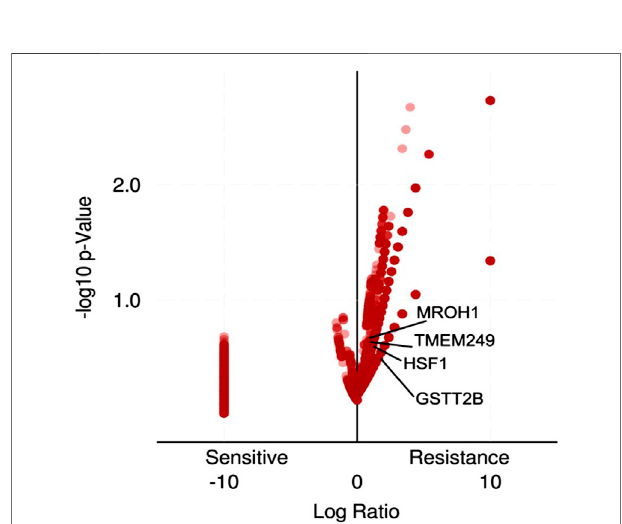
FIGURE 7 | Volcano plot enrichment analysis for gene-related protein expression in ovarian cancer patients who were treated with chemotherapy from TCGA using TCGAbiolinks. The expression of HSF1, TMEM249, and MROH1 proteins signi fi cantly increased in resistant patients ( n = 90) versus sensitive patients to chemotherapy ( n = 194).